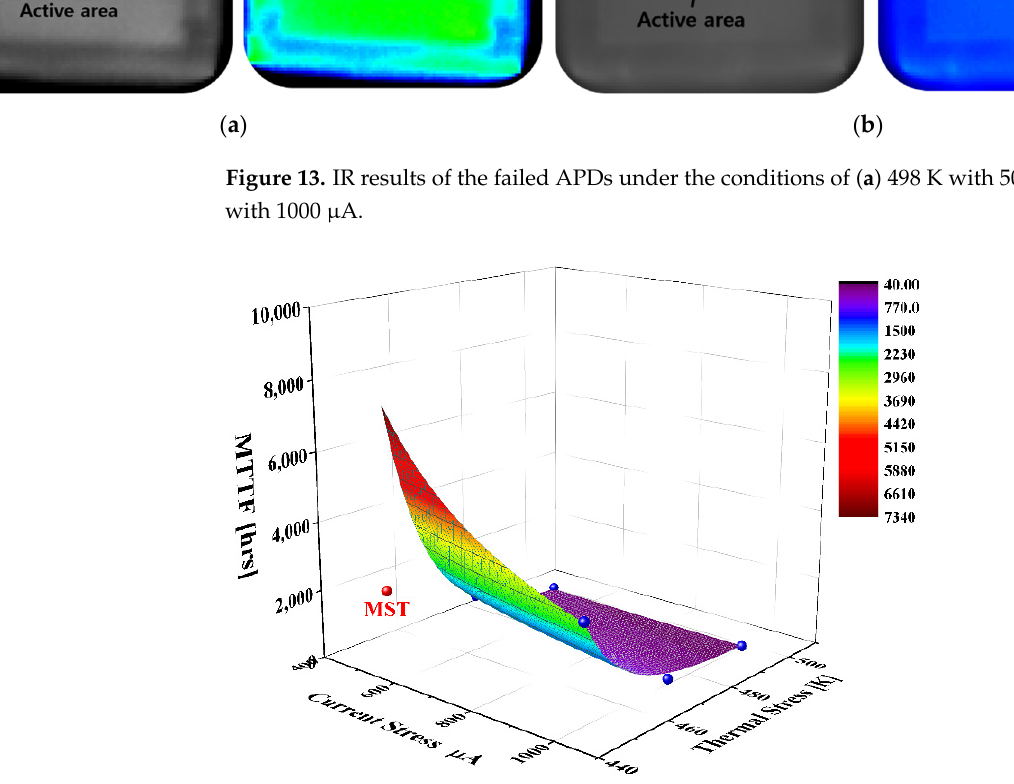
MST Figure 14. The results of the Eyring model for five distinct conditions with the projection of the MST